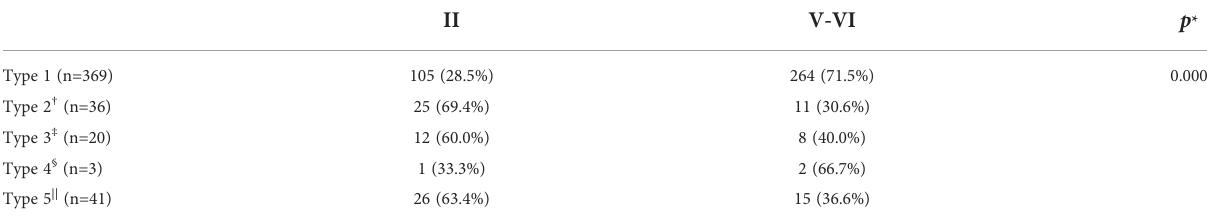
TABLE 2 Echogenic focus patterns and incidence of malignancy or suspicious for malignancy in nodules with echogenic